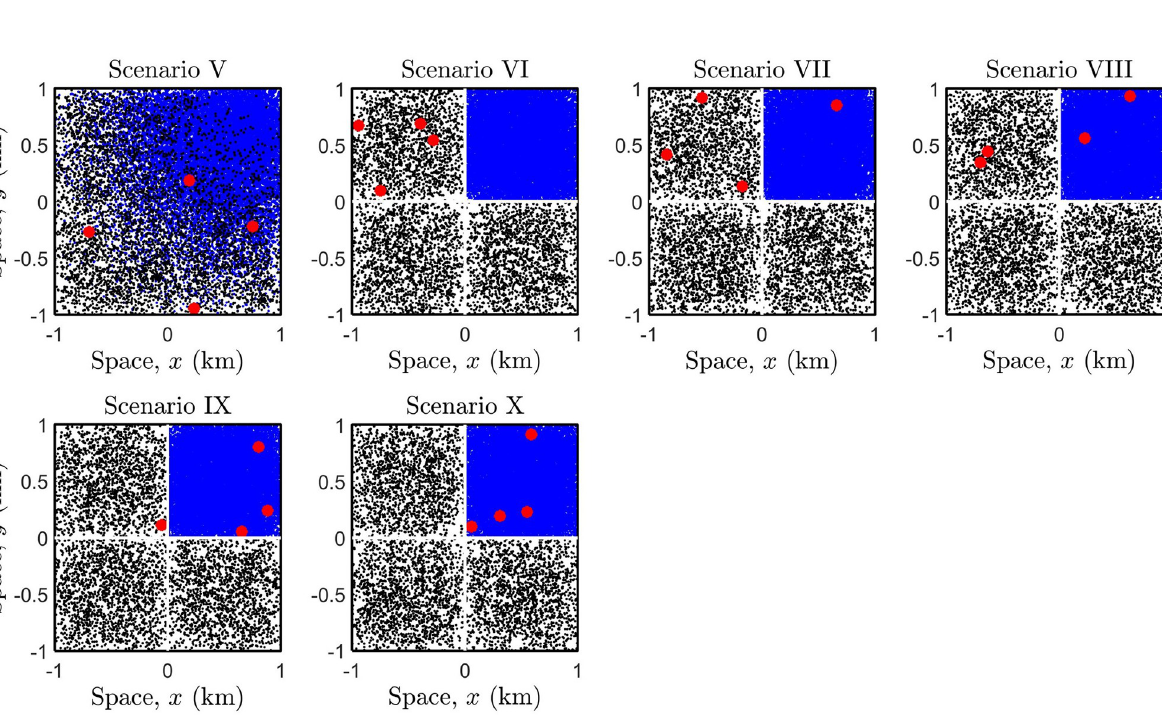
PLOS ONE | https://doi.org/10.1371/journal.pone.0258084 October 18, 2021 11 /